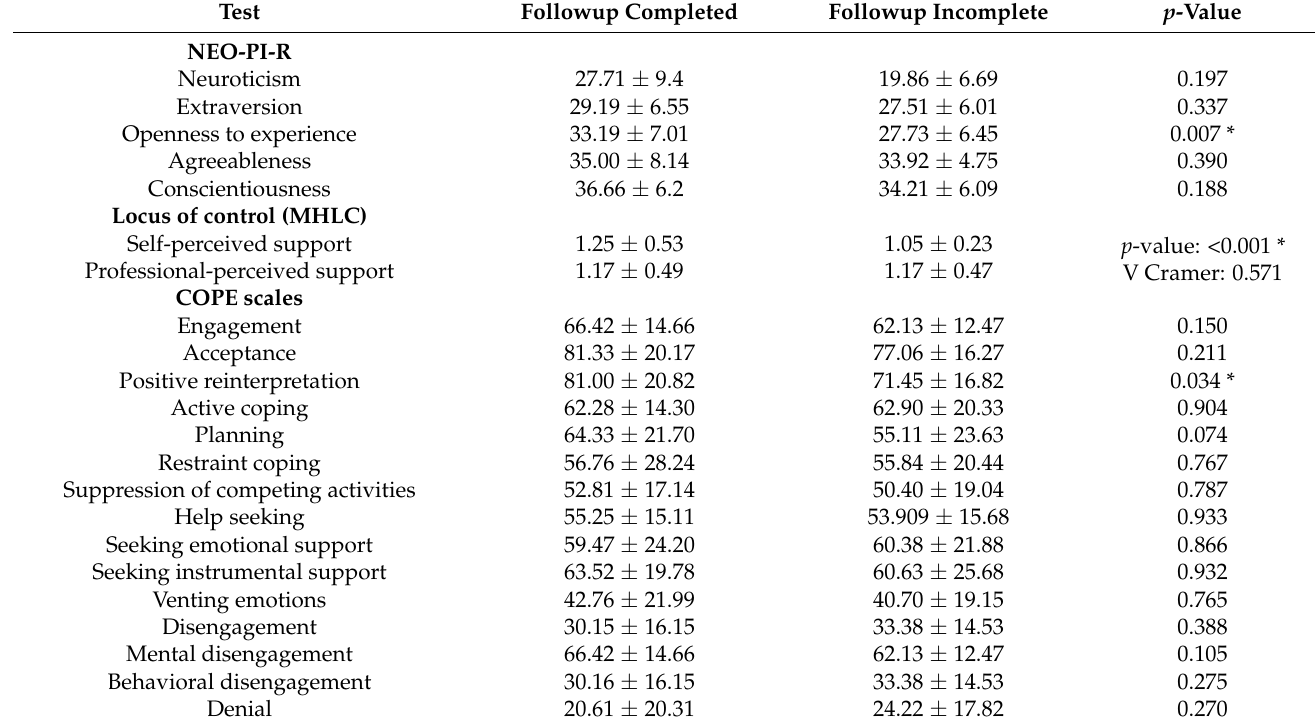
Table 2. Results of the test of the waiting